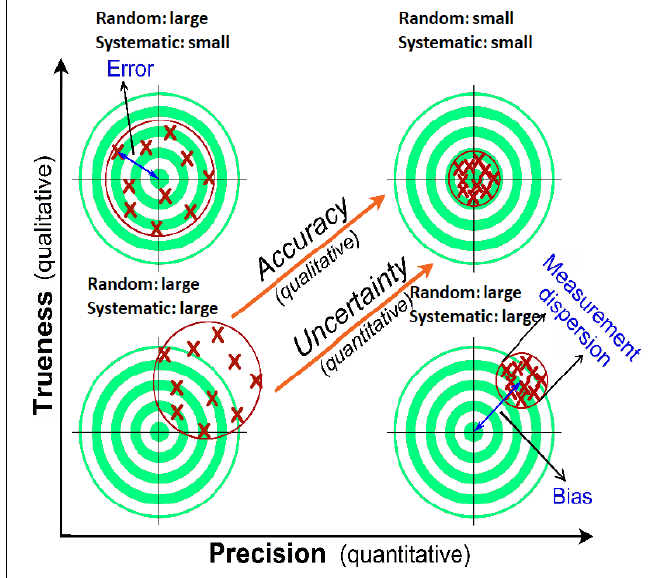
Figure 1: Accuracy and Precision, Systematic and Random